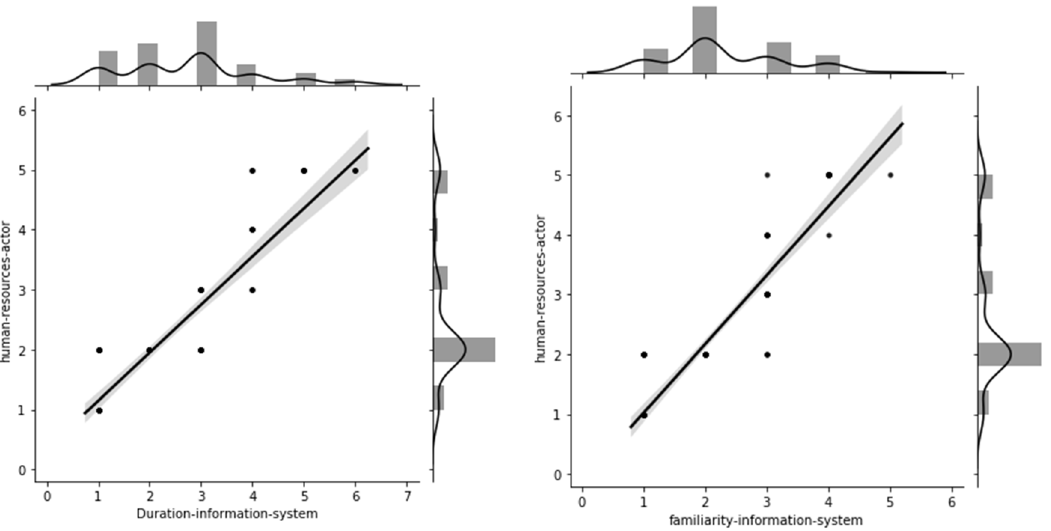
Figure 6. RF models performed for more significant features of human actors, including the period of AIS application and familiarity rate with AIS.